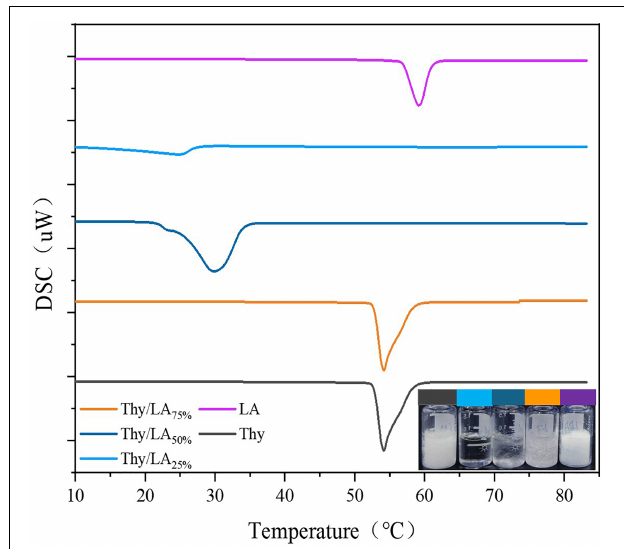
FIGURE 1 | Differential scanning calorimetry (DSC) thermograms of thymol/lauric mixture (Thy/LA) with different mass ratios and the appearance of thymol/lauric acid mixture with different mass ratios at room temperature. All line colors correspond to the samples. n = 3.